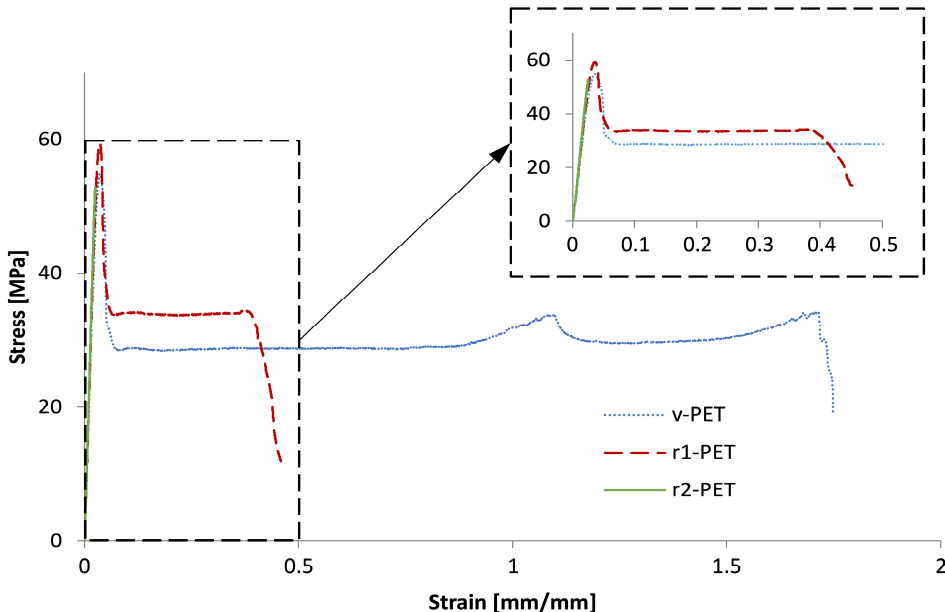
Figure 6. Stress–strain curve of each of processing cycle of PET. Table 5. Mechanical properties for virgin and recycled materials tested according to the guidelines in ISO 527:2019 [23].